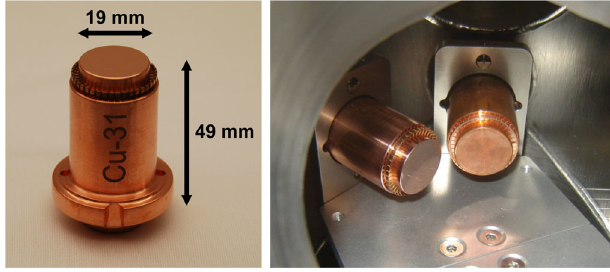
FIG. 6. SwissFEL gun cathode plug (copper, no coating), with dimensions indicated (left). Two cathode plugs mounted in the carousel holder of the load-lock chamber (right, see also Fig. 7). The rf contacts can be recognized around the circular cathode surfaces.